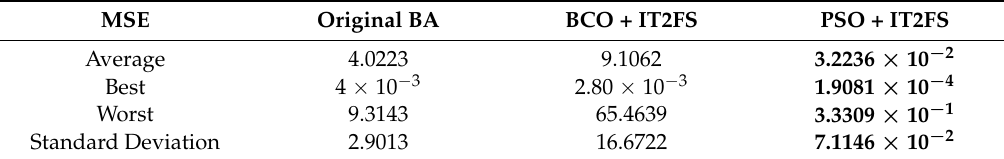
Table 14. Comparison of best methods applied to the plant without noise.